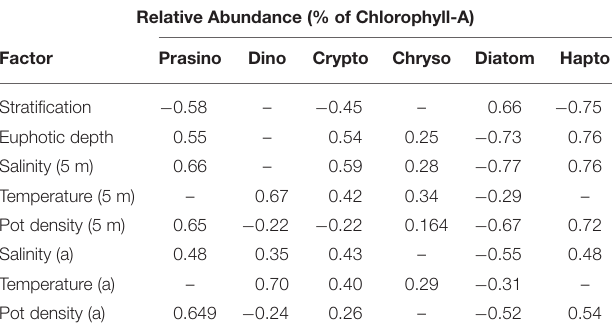
TABLE 2 | Correlation coefficients of Spearman rank order correlation between relative abundance of prasinophytes, dinoflagellates, cryptophytes, chrysophytes, diatoms, and haptophytes at station M and station G (5, 25, 50 m) between April 14 and June 10, and stratification strength, euphotic zone depth, surface salinity, temperature, and potential density (5m), and salinity, temperature, and potential density at actual depth (a); ( n = 102).